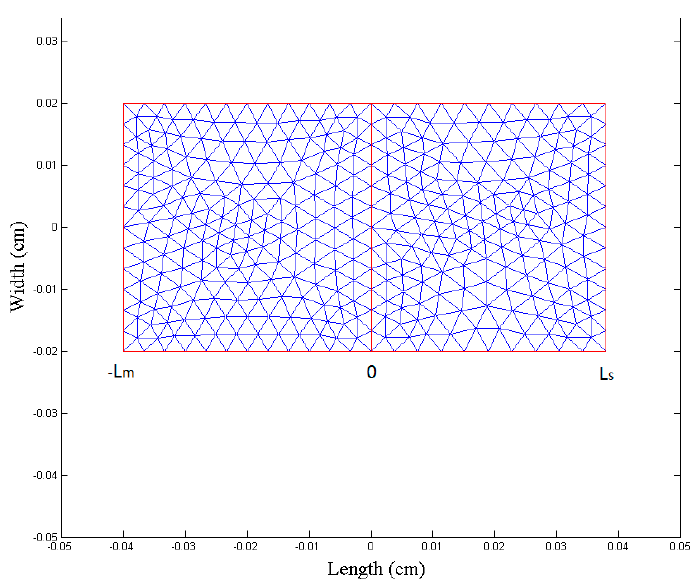
Figure 8. Finite elementary mesh of the finite element solutions